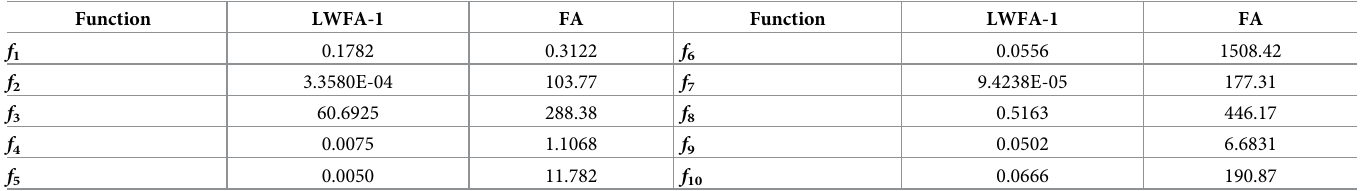
Table 1. The comparison results of LWFA-1 and FA with D = 30.